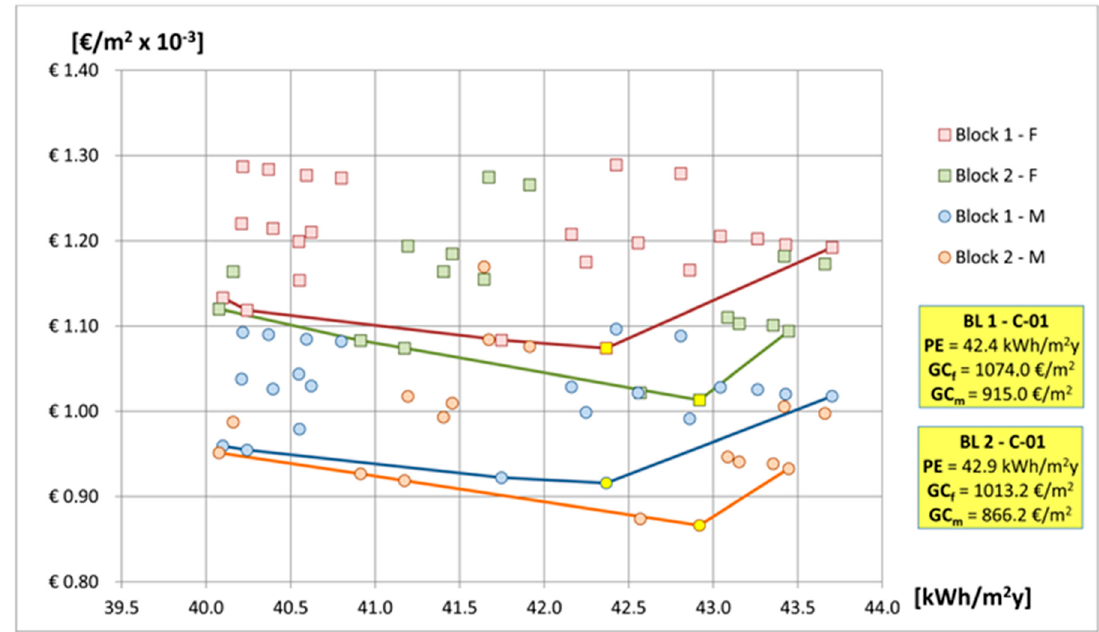
Figure 3. Cost-optimal level and best solutions for reference building 2.